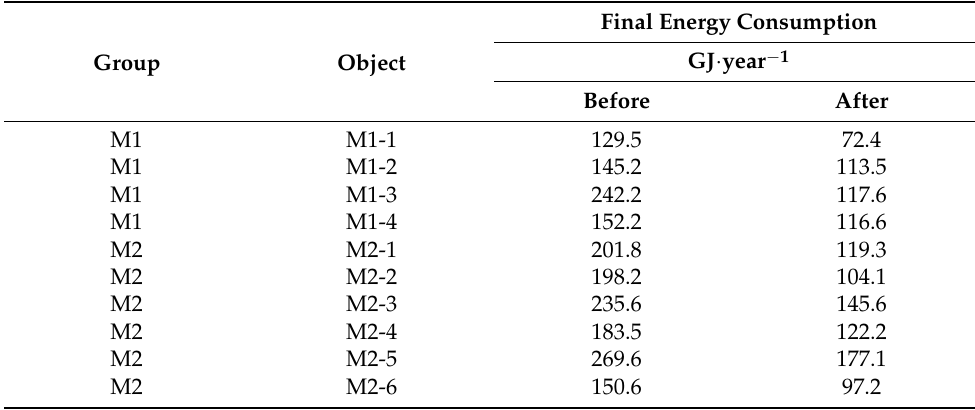
Table 9. Average values of the PE H index [kWh · m − 2 · year − 1 ].